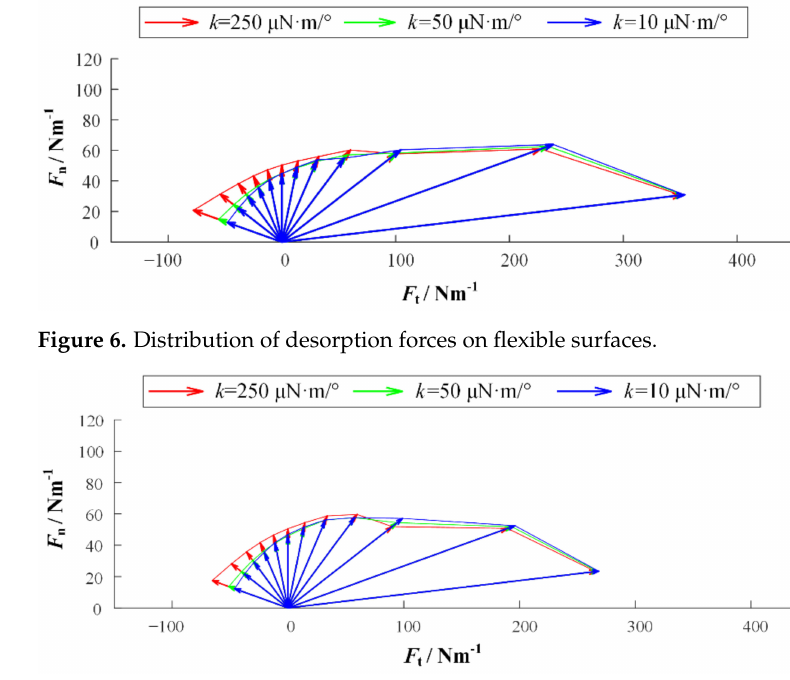
Figure 7. Distribution of desorption forces on super flexible